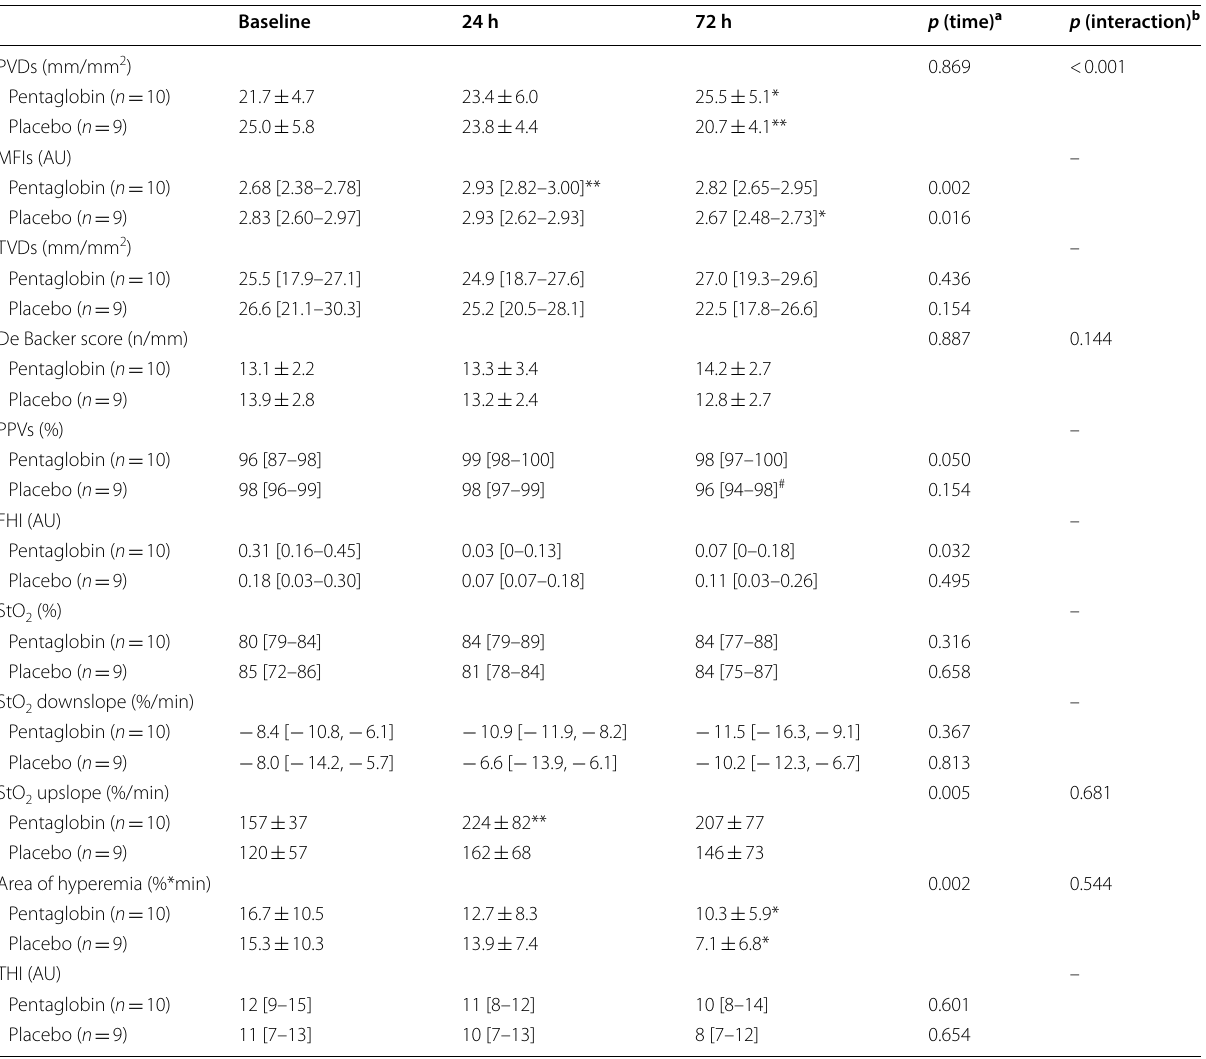
Table 2 Changes in sublingual microcirculation and NIRS-derived